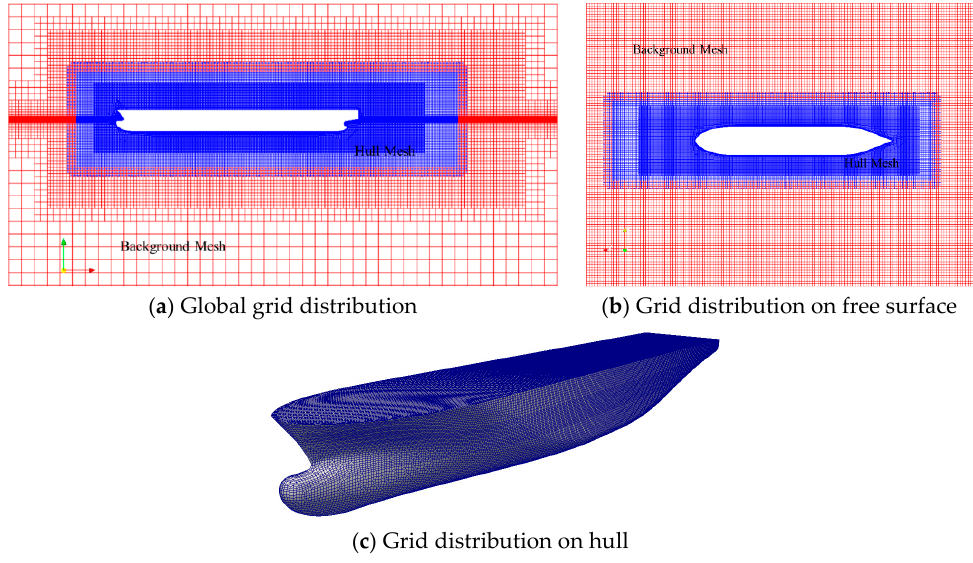
Figure 3. Grid distribution: ( a ) global grid distribution; ( b ) grid distribution on the free surface; ( c ) grid distribution on the hull.